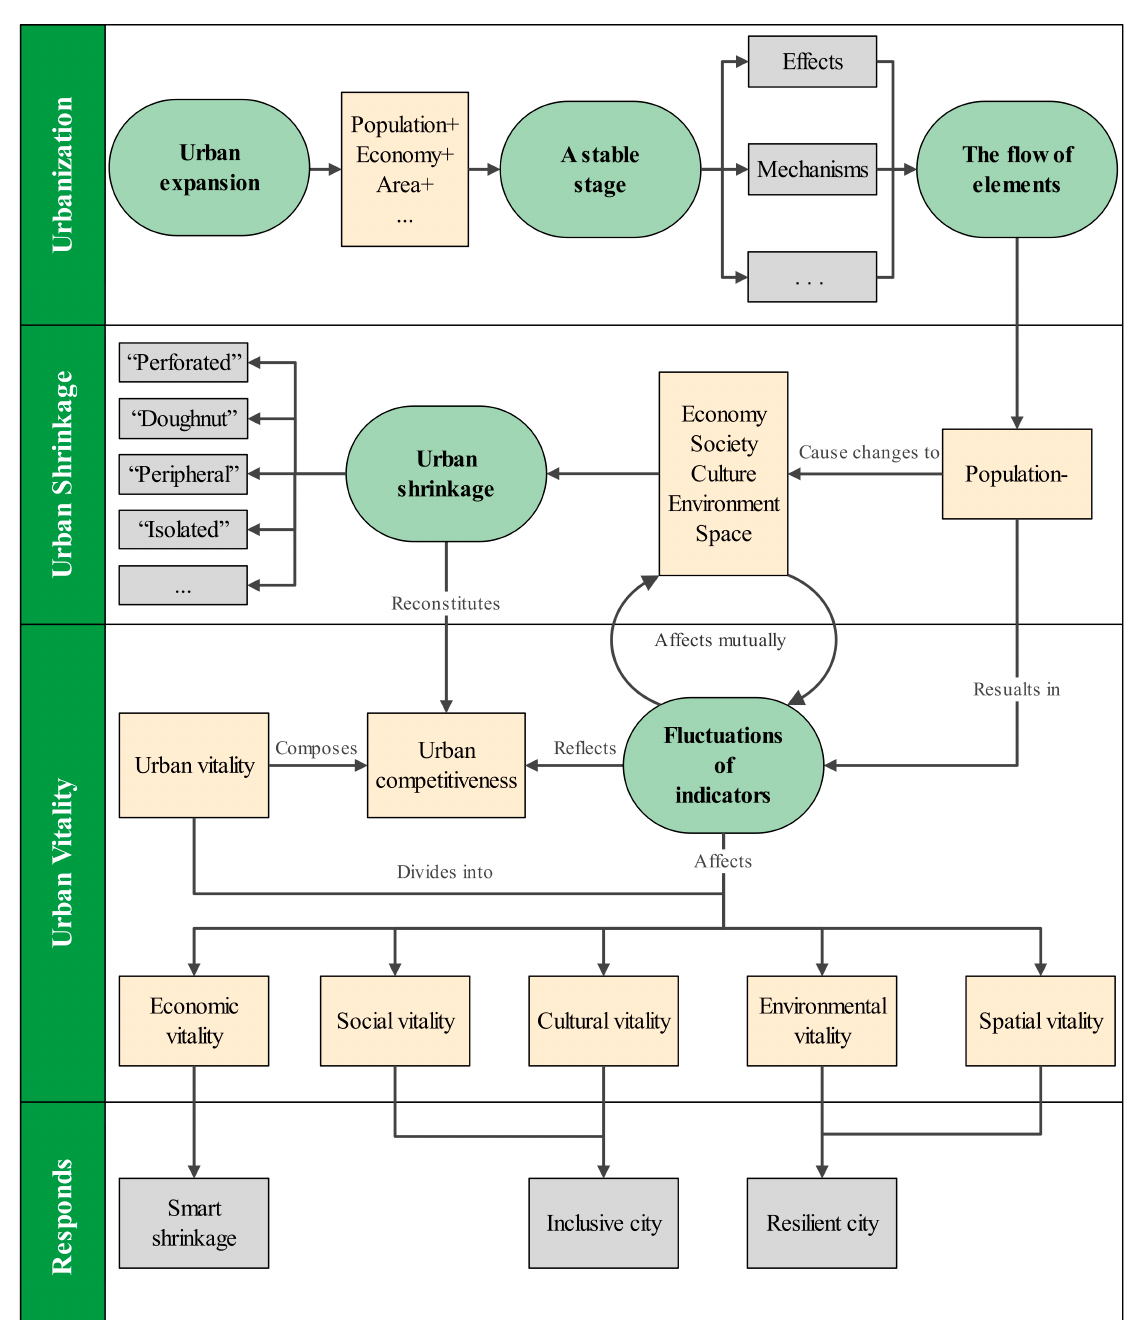
Figure 1. The theoretical connection between urban shrinkage and urban